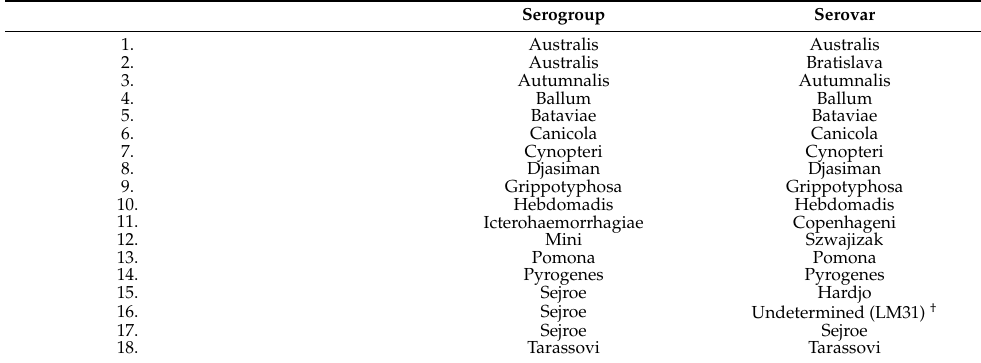
Table A1. Leptospira serovars and serogroups in the microscopic agglutination testing (MAT) panel used by USDA-ARS-NADC in the testing of livestock serum samples in St. Croix, U.S. Virgin Islands.